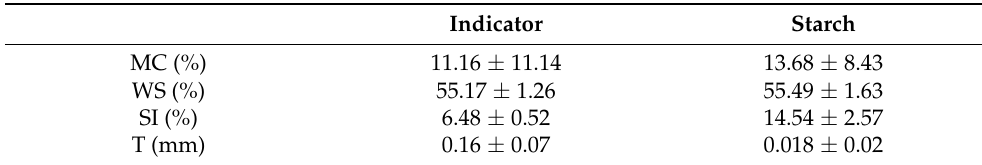
Table 1. Moisture content (MC), water solubility (WS), swelling index (SI), and thickness (T) of indicator and starch